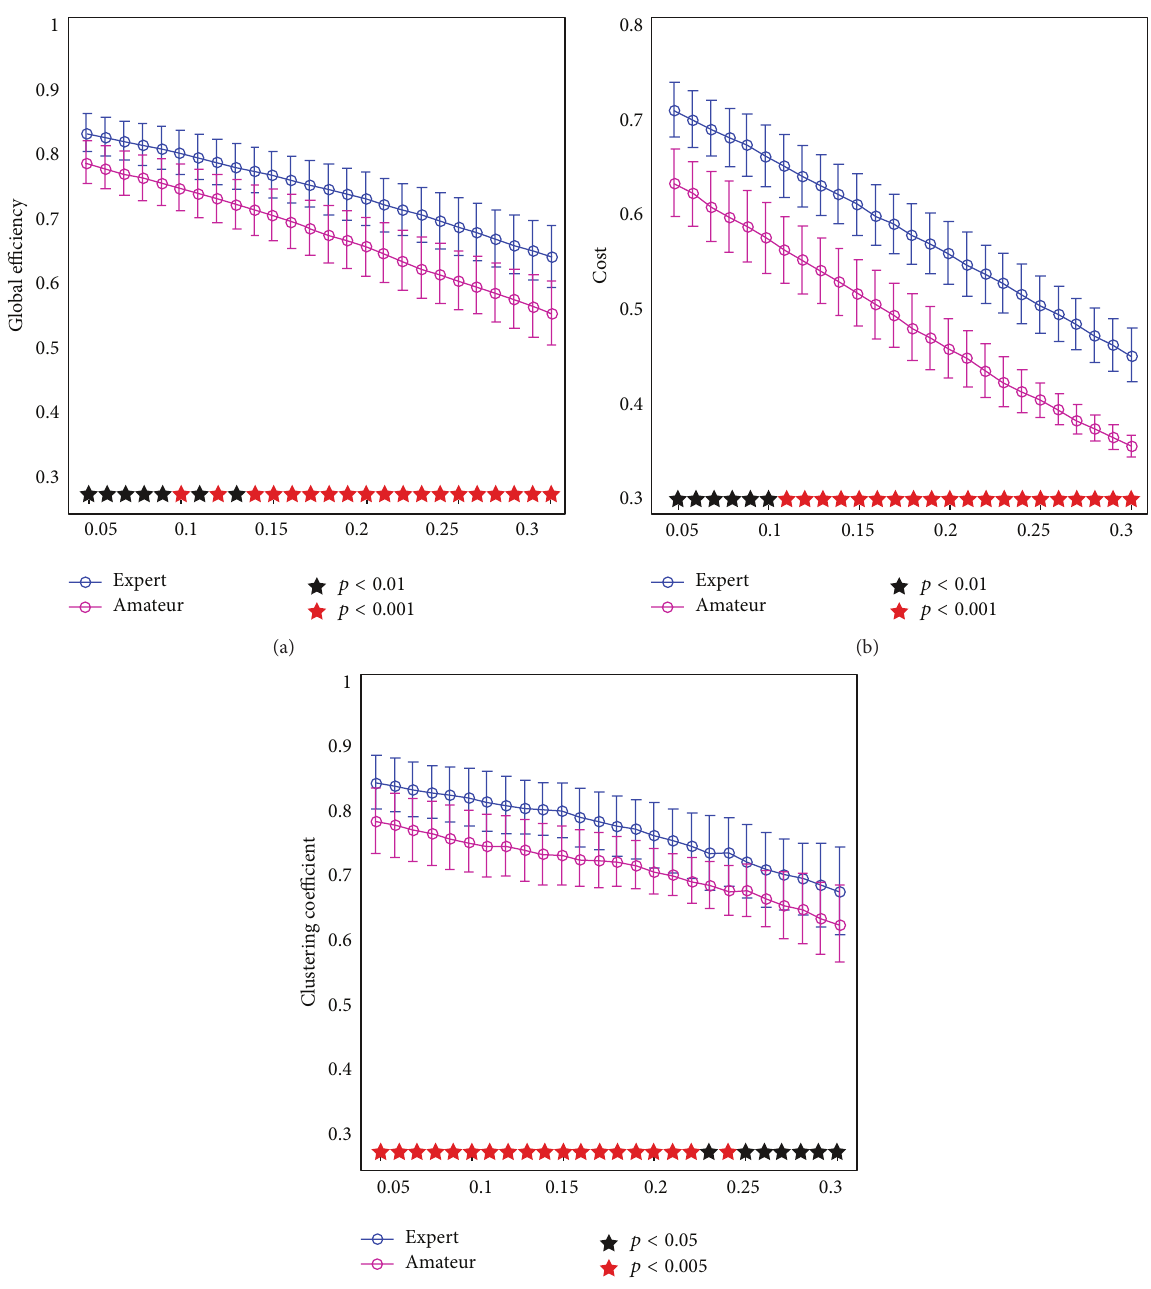
Figure 1: Increased global characteristics in AVG experts over amateurs. (a), (b), and (c) indicate global efficiency, connection cost, and mean clustering coefficient, respectively. The abscissa indicated step-by-step thresholds (correlation coefficient) to establish a network.